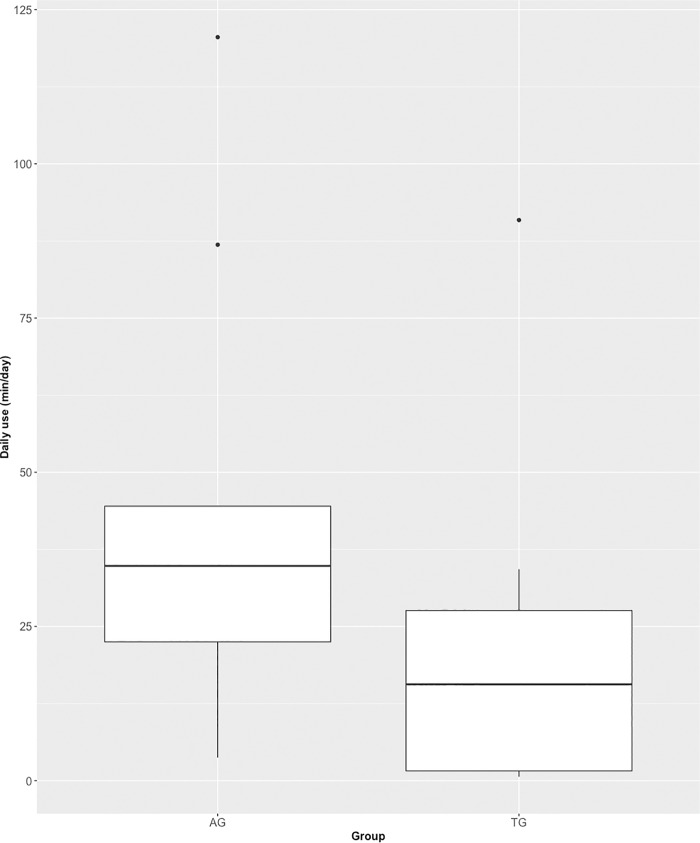
Daily use (min/day), separately for assistive group (AG) and therapeutic group (TG).